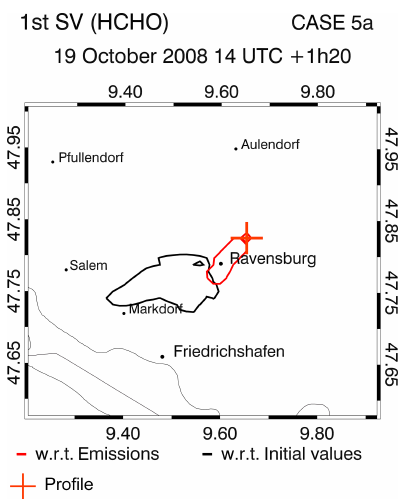
Figure 7. Optimal horizontal placement of emissions and initial val- ues for HCHO at surface level for case 5a. The 0.01 isopleths of the optimal horizontal placement are indicated with a black line (initial values) and a red line (emissions). The horizontal position of the final profile VP( t F ) is indicated with a red